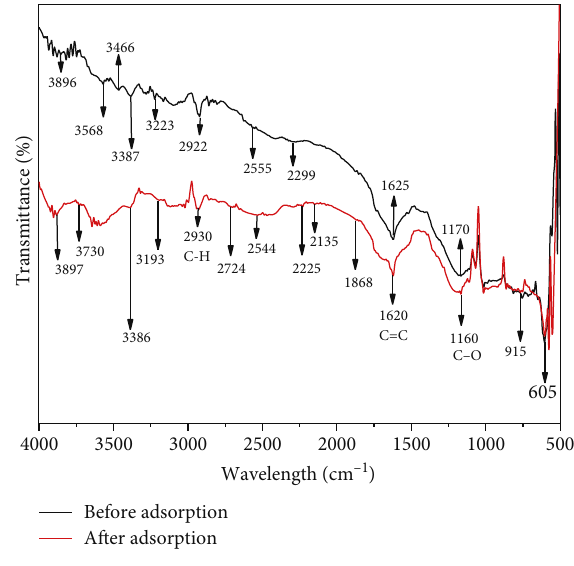
Figure 3: FTIR spectra of